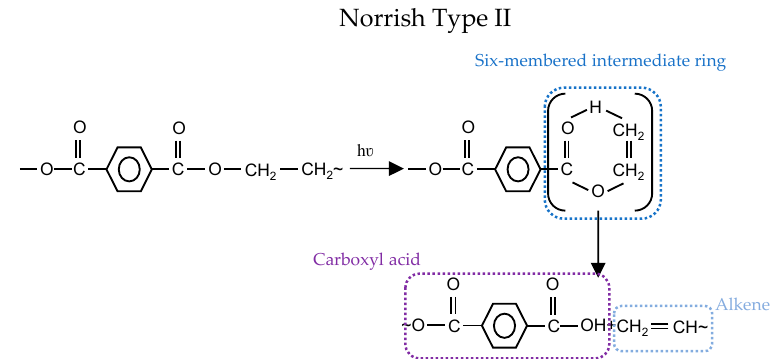
Figure 5. Photochemical degradation mechanisms: ( top ) Norrish Type I; and ( bottom ) Norrish Type II [22].